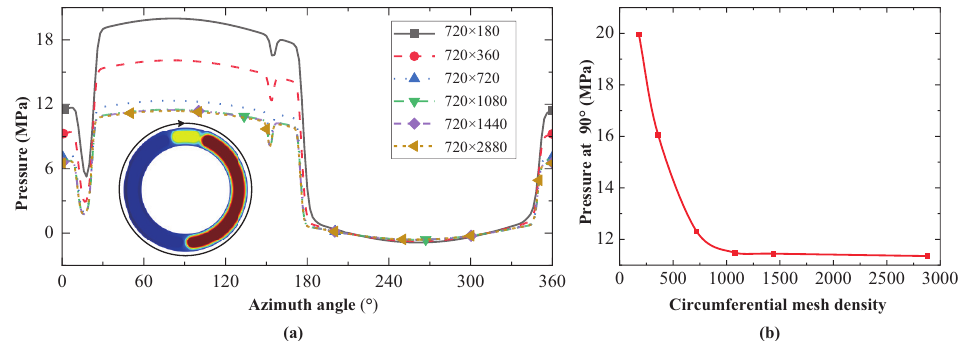
Figure 12. Mesh independence test results of the circumferential mesh. ( a ) Variation in circumferential pressure with mesh density. ( b ) Mesh pressures at the 90 ◦ phase.